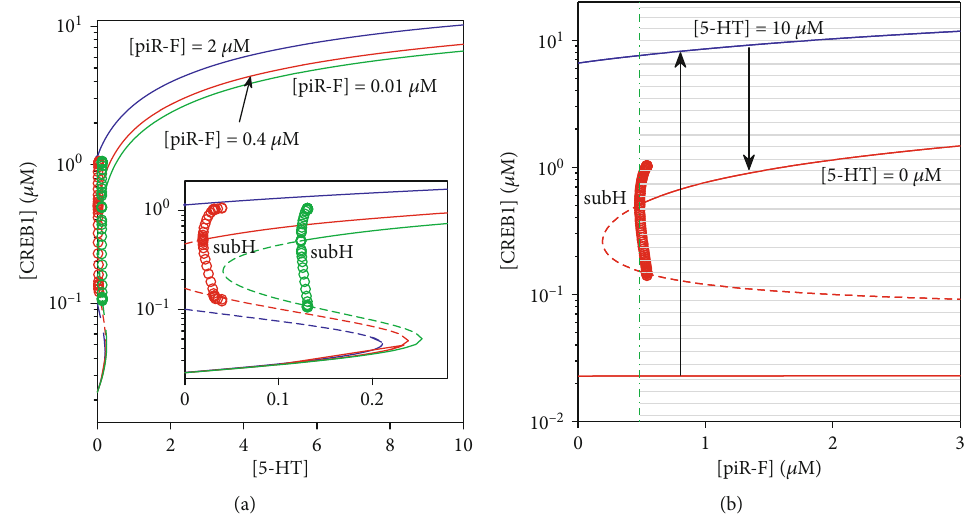
Figure 7: Bifurcation diagrams of [CREB1] versus [5-HT] for di ff erent [piR-F] (a) and [CREB1] versus [piR-F] at ½ 5 ‐ HT (cid:2) = 0 μ M (red lines) and ½ 5 ‐ HT (cid:2) = 10 μ M (blue lines) (b). Stable and unstable steady states are represented by solid lines and dashed lines, respectively. For the unstable limit cycles, the maximum and minimum values of [CREB1] are denoted by open